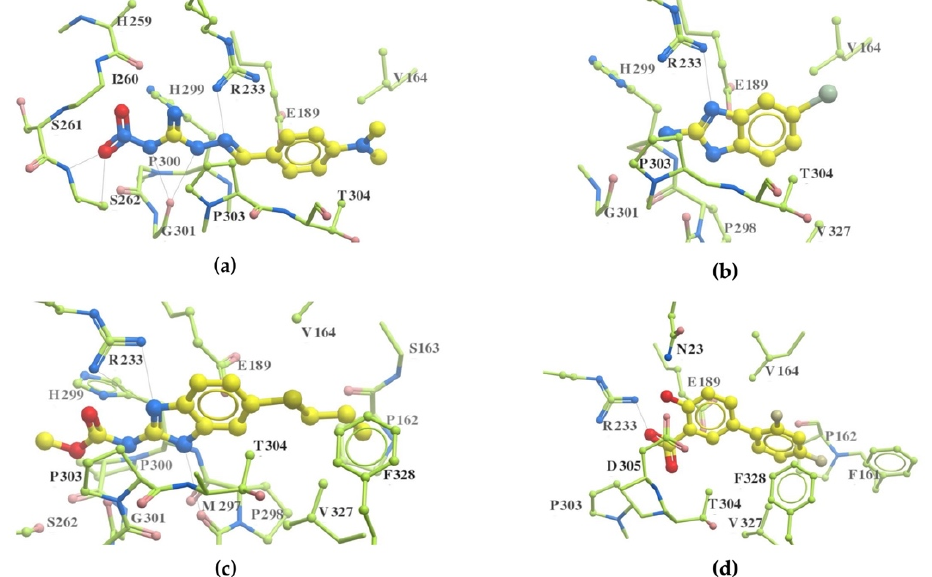
Figure 1. Putative MurA inhibitors bind to MurA substrate-binding site. The compounds (yellow) were docked into the UNAG-binding site of MurA enyzme (green) and evaluated binding affinity. Based on docking models, ( a ) compound C1, 2-[4-(dimethylamino)benzylidene]- N -nitrohydrazinecarboximidamide, binds to residues R233, S261, and G301; ( b ) compound S17, 2-amino-5-bromobenzimidazole, interacts with residues R233 through hydrogen bond; ( c ) compound S4, albendazole, has hydrogen bonding with residues R233 and M297; ( d ) compound S8, diflunisal, forms hydrogen bonds with residues R233. Hydrogen bonds are marked as a black dotted line.